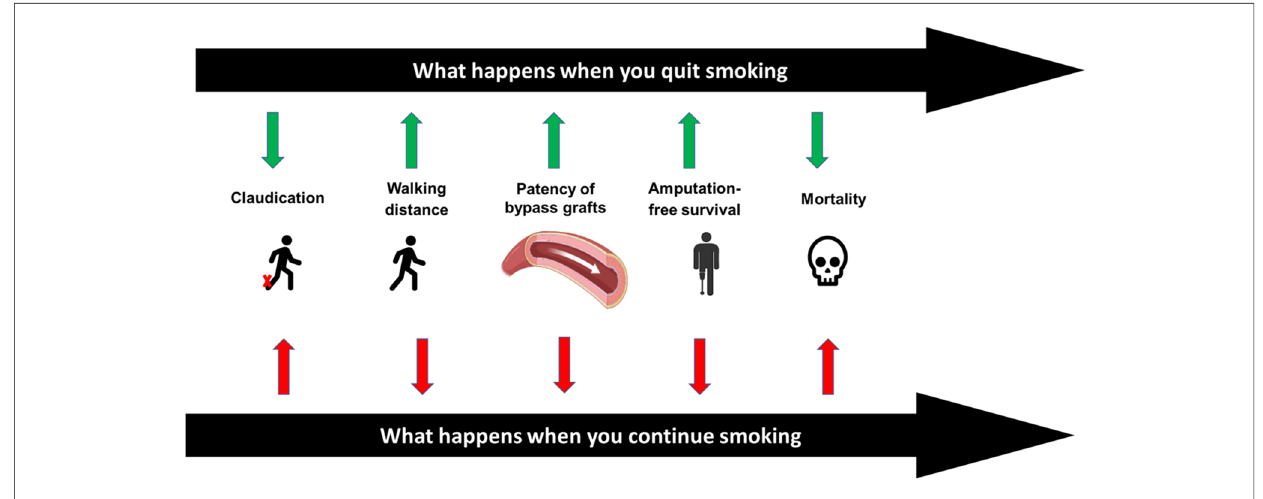
FIGURE 2 Bene fi ts of smoking cessation on clinical outcomes in patients with